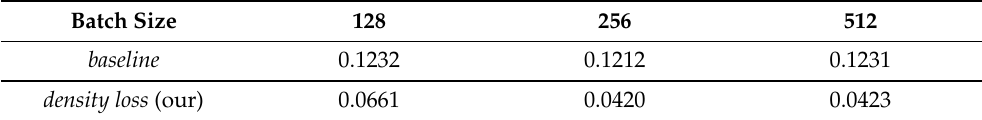
Table 4. Influence of batch size on EUROSAT with RESNET50 backbone: we can see that results are relatively stable across batch sizes from 128 to